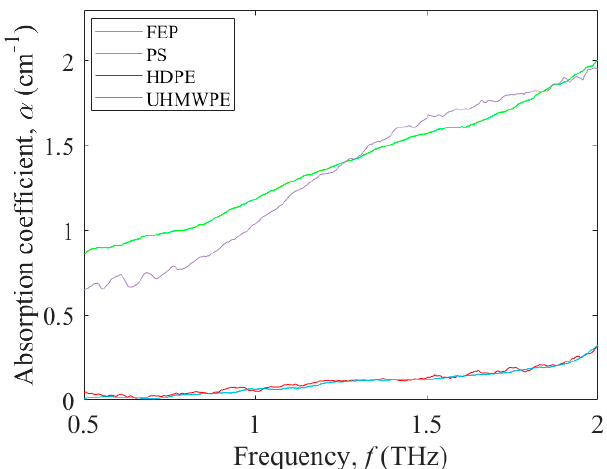
Figure 3. Terahertz absorption coefficient, α , versus frequency, f , from 0.5 to 2.0 THz for the nonpolar polymers: FEP (green curve), PS (purple curve), HDPE (red curve), and UHMWPE (blue curve).